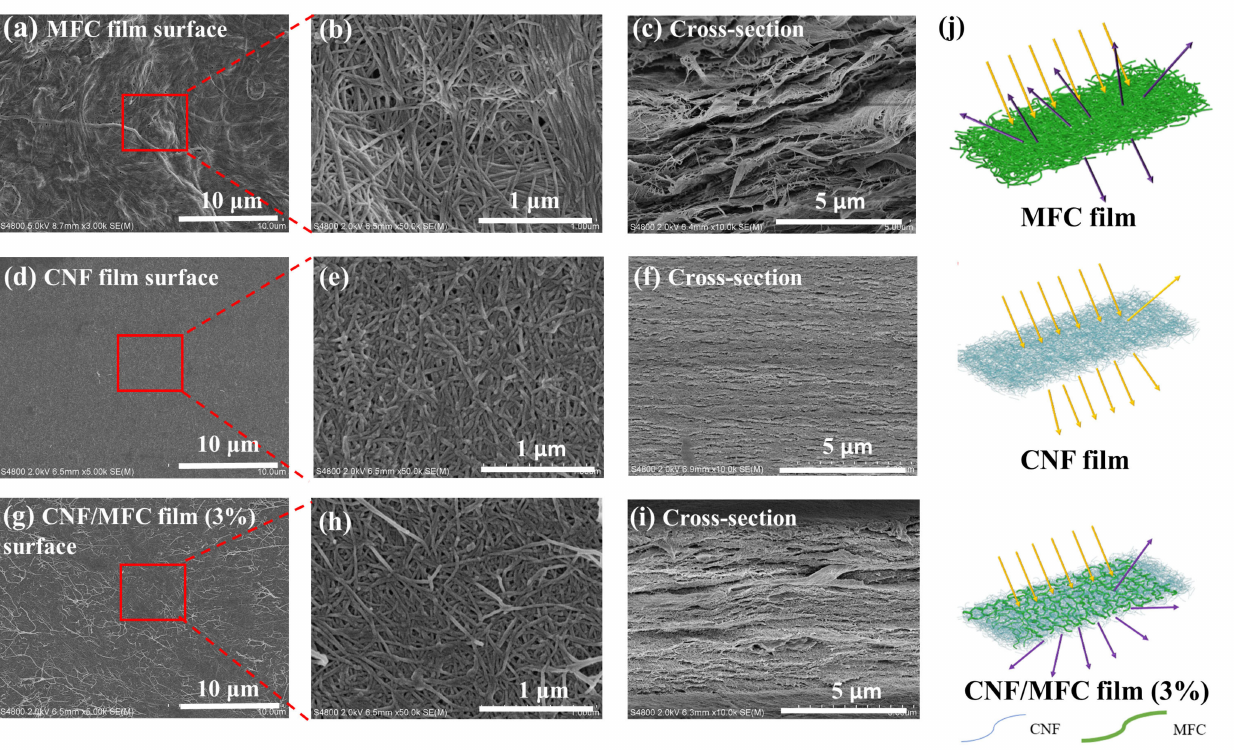
Figure 4. SEM images of MFC film ( a – c ), CNF film ( d – f ), and CNF/MFC composite film with 3 wt.% MFC ( g – i ), Schematic diagrams of MFC film, CNF film and the CNF/MFC composite film ( j